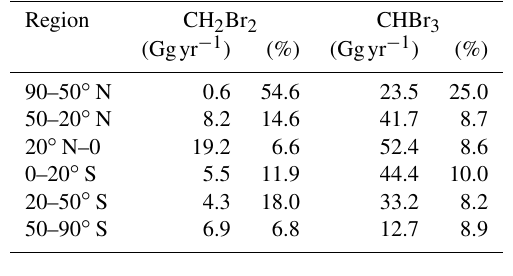
Table 2. Average absolute flux for the year 2000 in Ggyr − 1 and percentage of relative increase in VSLS flux between 2000 and 2100 from SC_free. The numbers have been obtained by linear regression of the data shown in Fig. 2 and evaluated at the given years.